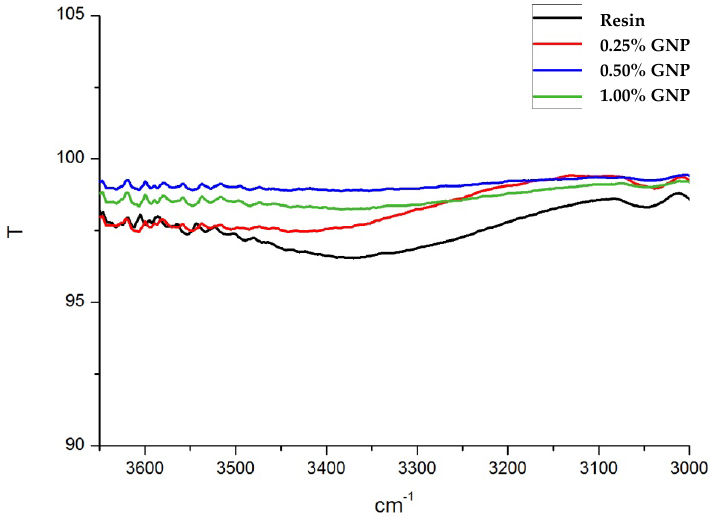
Figure 23. Comparison of IR signals of water stretching in resin a in composites after 31 days of aging. It can be seen that the pure epoxy sample shows the peak relative to the water